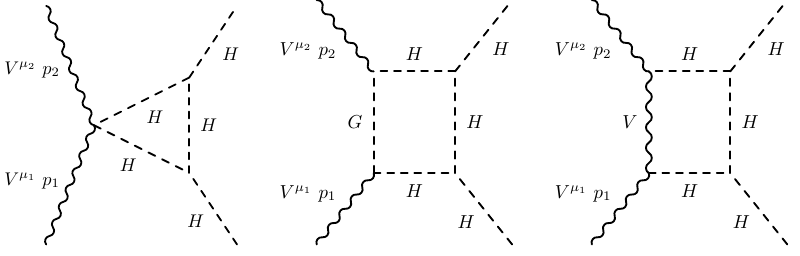
Figure 22 . Representative Feynman diagrams contributing to the V 20 [ HHV V ] form